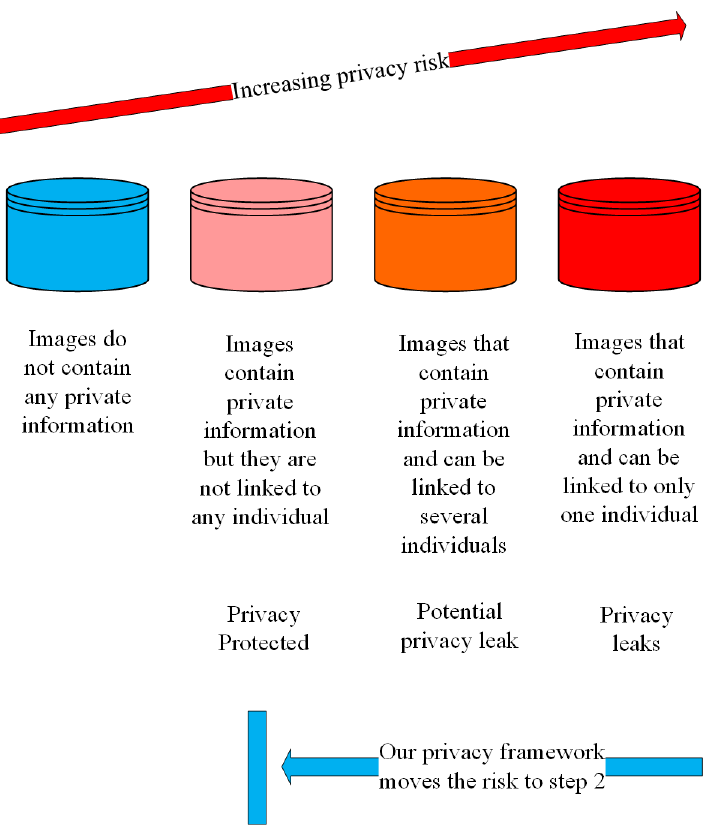
Figure 2. The four levels of image privacy